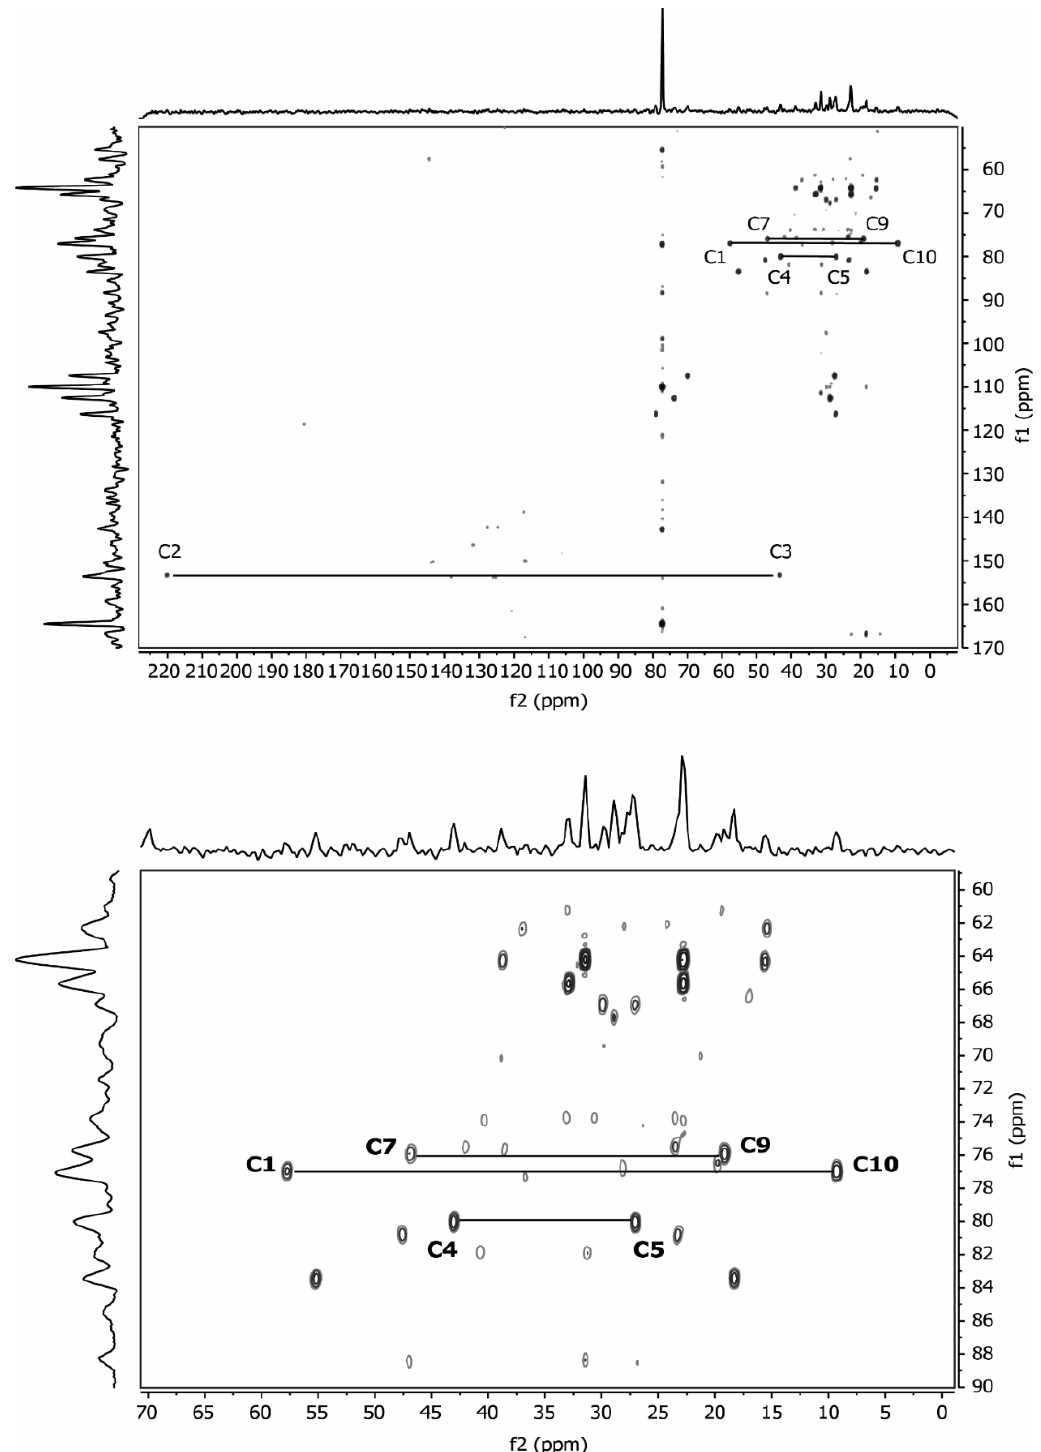
Figure 6. INADEQUATE 13 C NMR camphor signals; chloroform-d leaf essential oil extract from spike lavender after incorporation of 13 CO 2 (pulse 5.2 h, chase 192 h. (NMR parameter: pulse program: inadqf, TD1: 300, NS: 128, J (CC): 50 Hz, D1: 2 s), measurement time: 22 h.